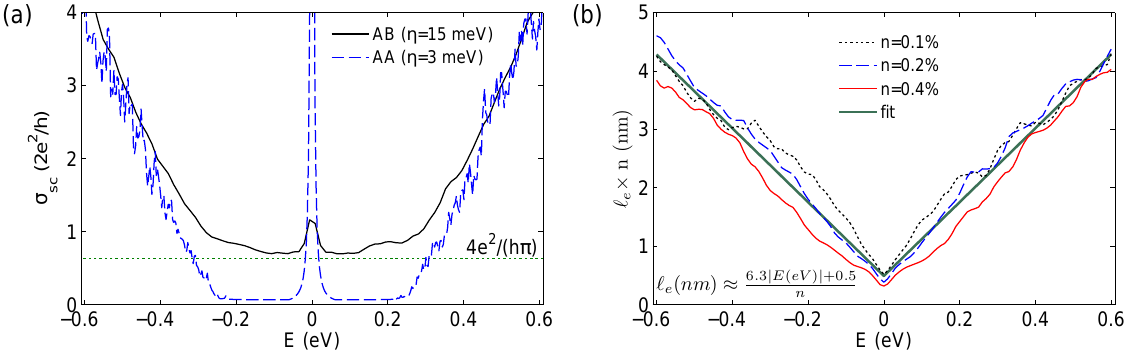
Figure 5. ( a ) Semi-classical conductivity as a function of the energy in the presence of compensated and uncompensated vacancies with density n = 0.8%; ( b ) Scaled mean free path as a function of energy and for different compensated vacancy densities, and its linear